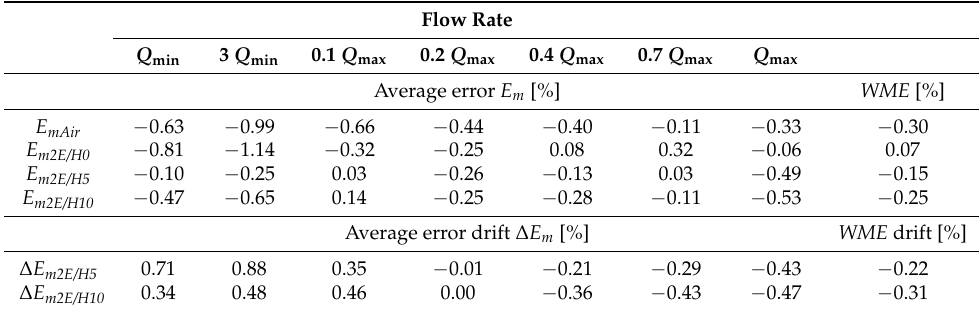
Table 6. Average errors and average errors of indication drifts as well as WME s and WME s drifts of G4 ultrasonic gas meters tested with different gas